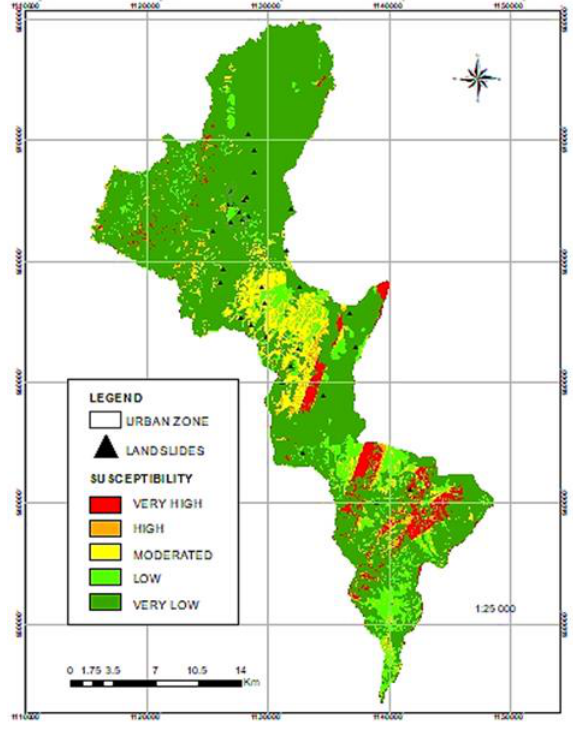
Figure 5. Susceptibility 2018-2 by